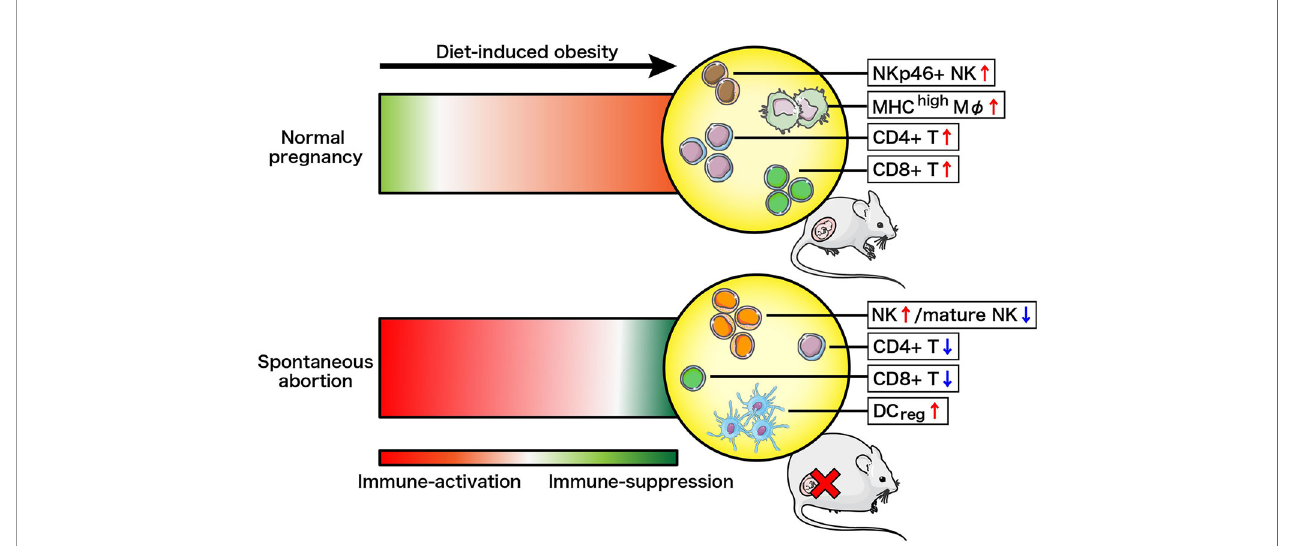
FIGURE 5 | Schema of how the maternal immune system changes driven by diet-induced obesity in normal pregnancy or spontaneous abortion. Immune- suppression and immune-activation changes are illustrated by red and green, respectively, with darker color changes re fl ecting more drastic